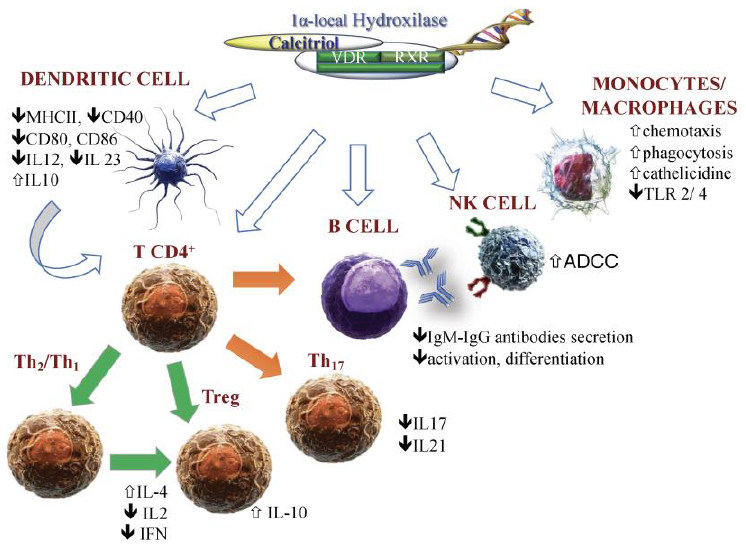
Figure 1. Vitamin D and immune cells crosstalk. Vitamin D (calcitriol) directly and indirectly influences and regulates both innate and adaptive immune cells, which widely express the vitamin D receptor (VDR). RXR — retinoic acid receptor; NK — natural killer cells; ADCC — antibody-dependent cell-mediated cytotoxicity; IL — interleukin; MHCII — major histocompatibility complex class II; Th — T helper; TLR — toll-like receptor; green arrow — stimulation; orange arrow — inhibition.